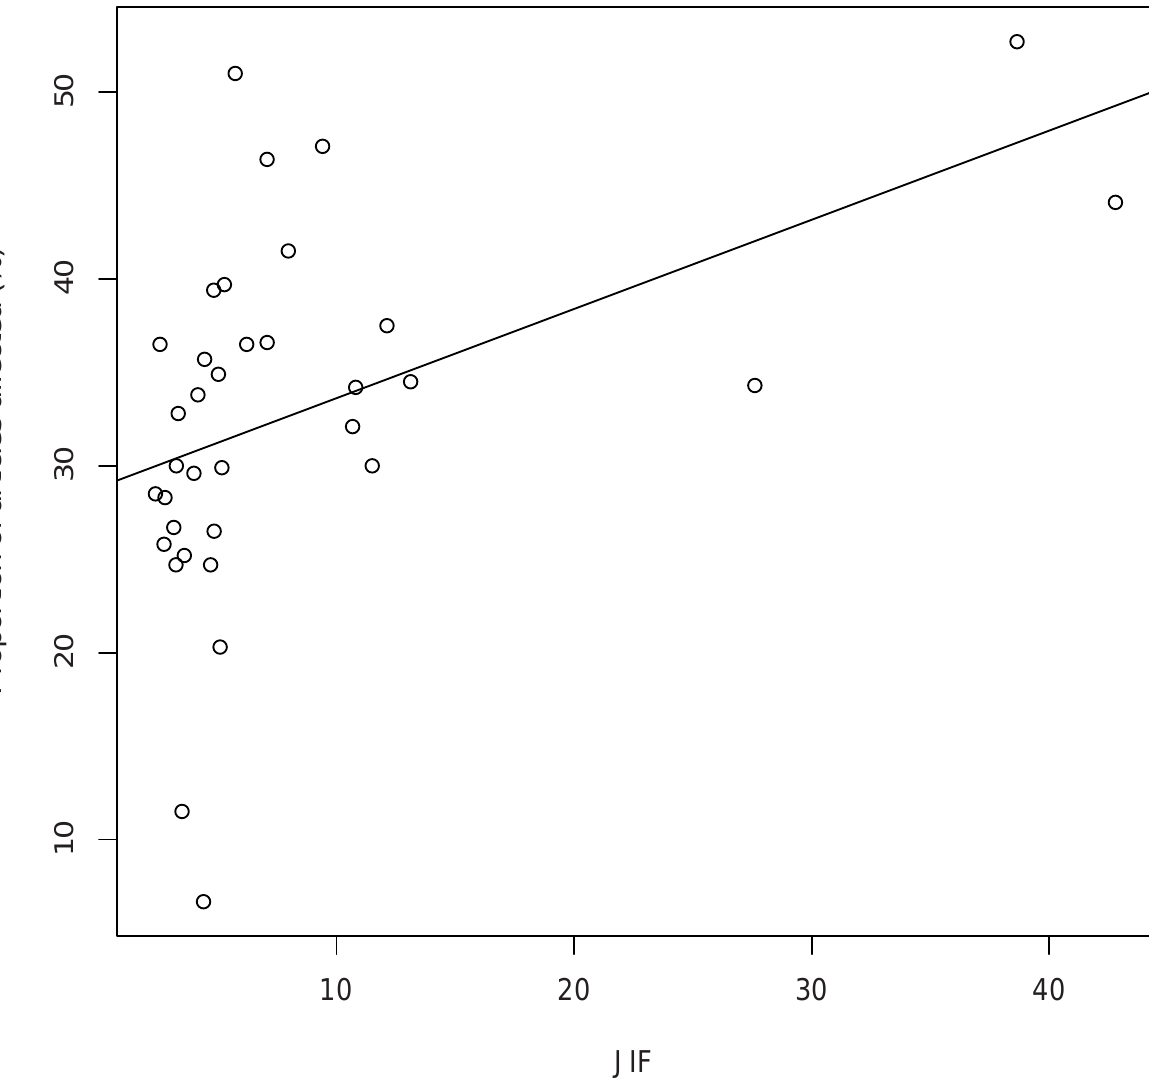
Fig 2. A scatterplot of JIF and proportion of articles with supplementary Excel gene lists affected by gene name errors.